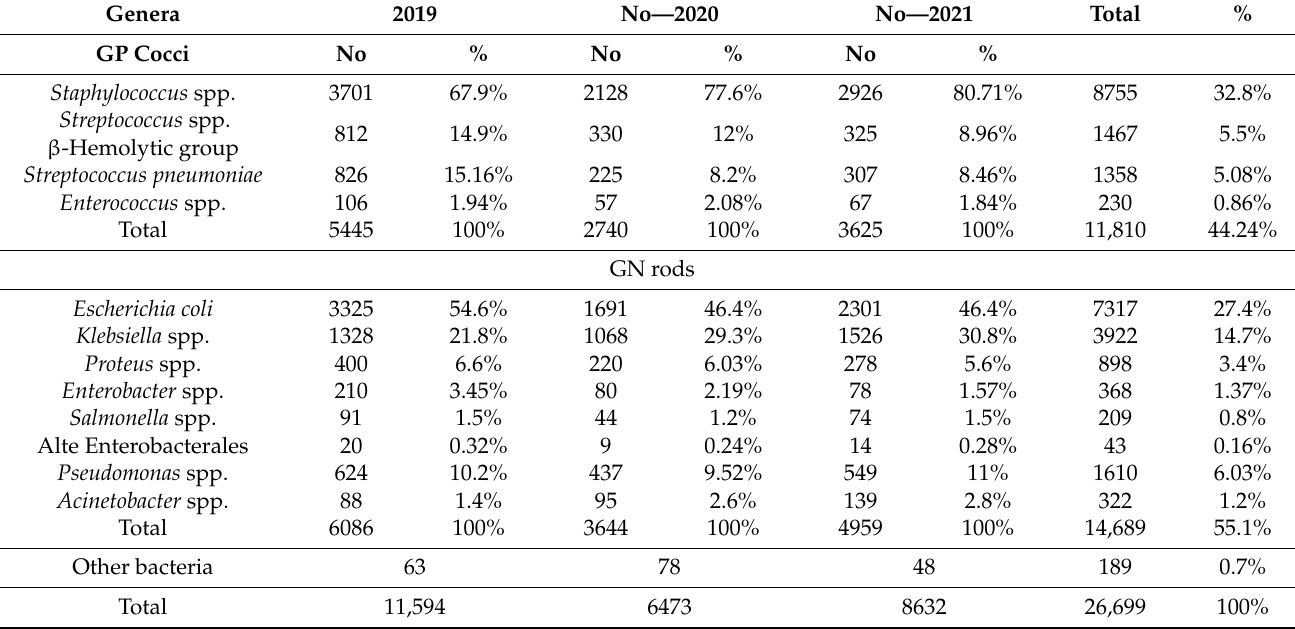
Figure A3. The distribution of Enterococcus spp. Table A1. Annual Frequency of Group